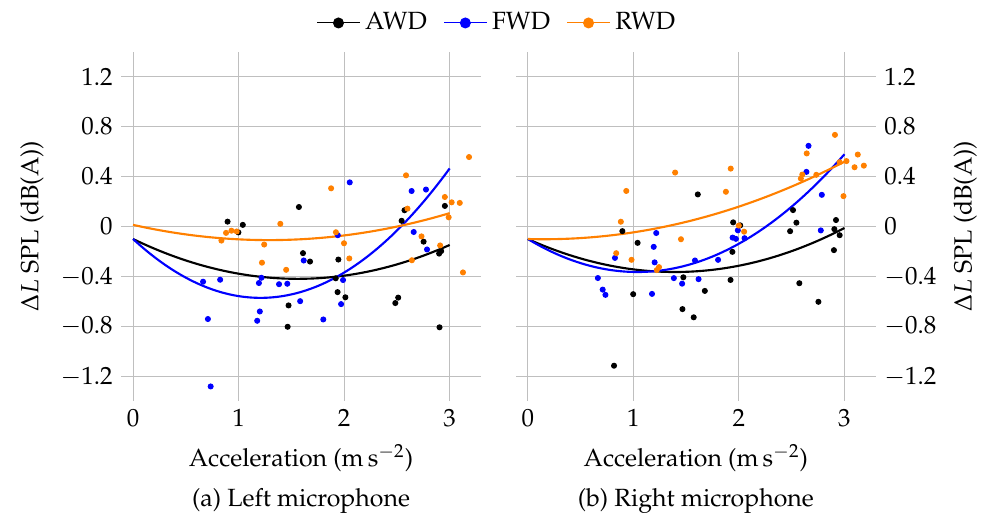
Figure 9. Air temperature corrected additional SPL caused through acceleration for the 285P mounted on the LSBEV for left and right microphone side on Point P-P’ of the measurement distance.